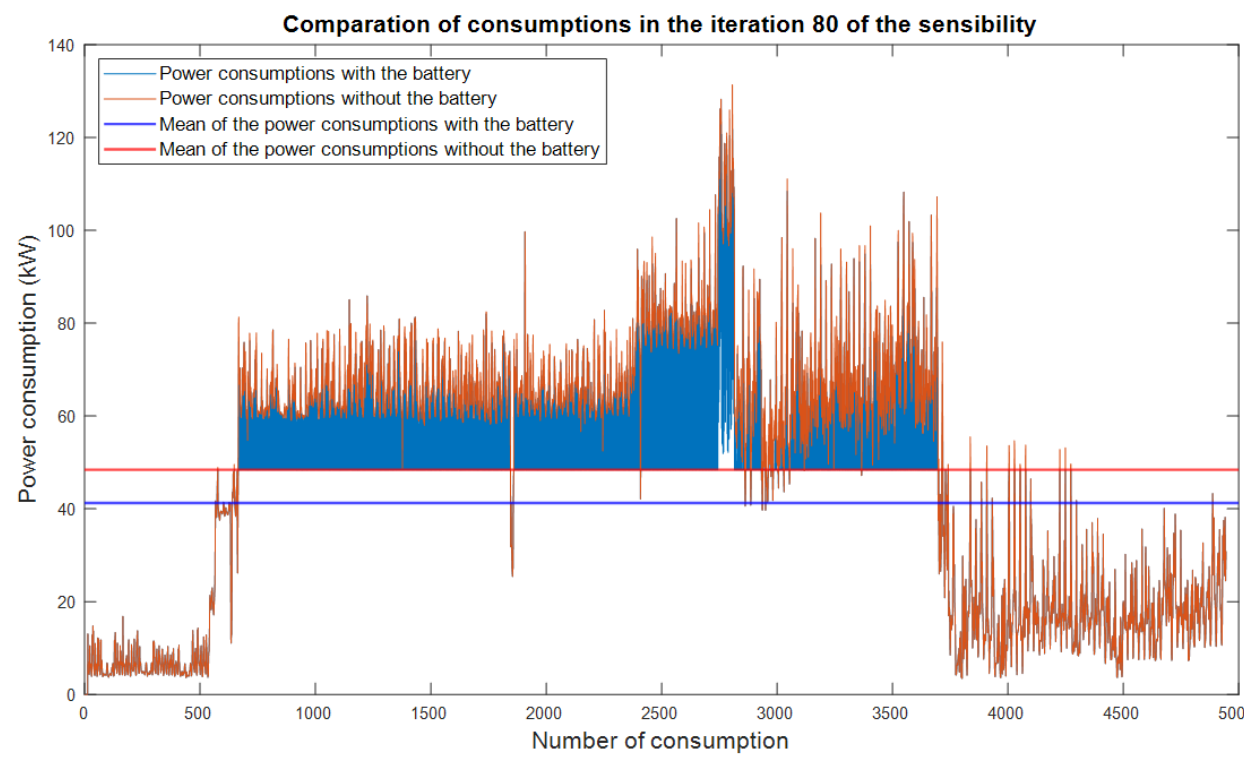
Figure 11. Power consumption (kW) comparison with and without the battery (iteration 80).